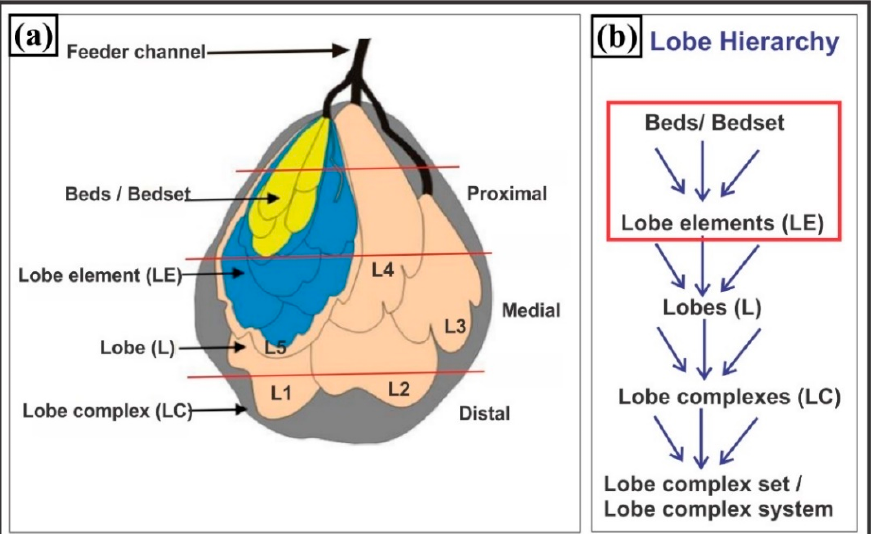
Figure 4. A sketch showing various components of a lobe system from proximal to distal zones. ( a ) Each lobe has the smallest units of bed or bedset which merge into lobe element (LE). Many lobe elements combine to form an individual lobe (L). These lobes are further stacked into a lobe complex [45,79] . ( b ) Lobe hierarchy starting from beds or bedset following to form a lobe. The lobe element is the basic building block of a lobe system while the lobe complex set or lobe complex system is the largest entity in lobe hierarchy.